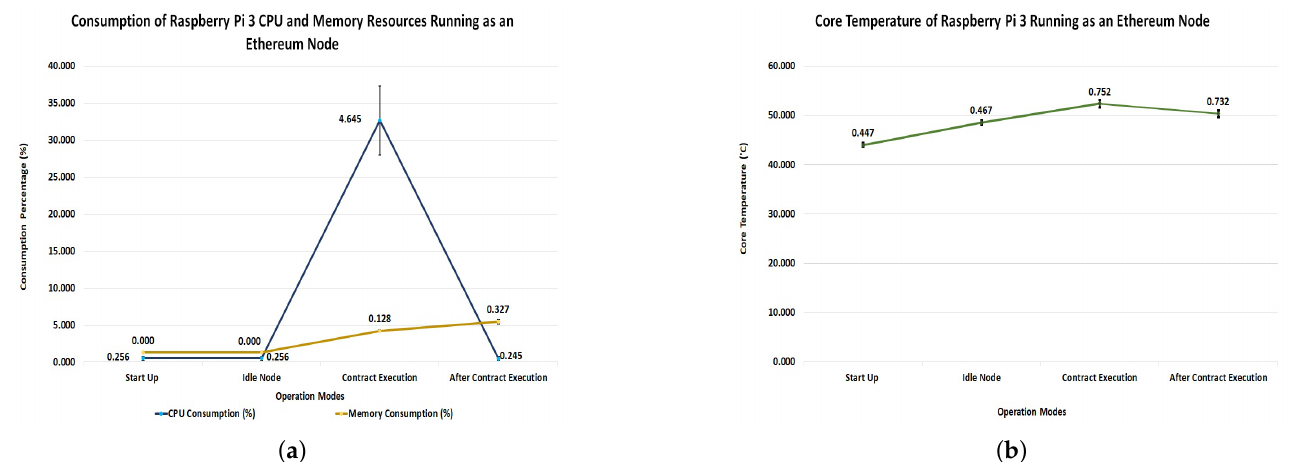
Figure 7. Performance testing experiment captures. ( a ) Htop capture of CPU and RAM memory consumption; ( b ) Execution time and voltage drop waveform for Ethereum transaction.